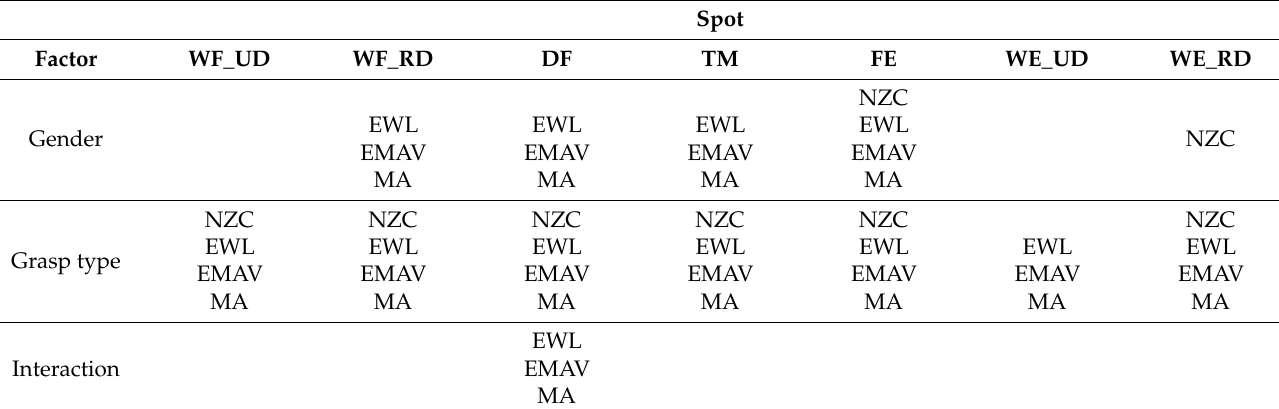
Table 2. Results in columns of the set of MANOVAs. The EMG characteristics that significantly differed between H_w and H_m are indicated. Abbreviations are defined the Figure 5